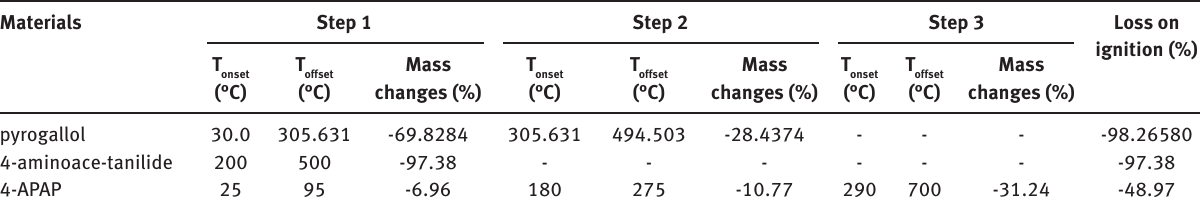
Table 1: Effect of temperature on mass changes TG curves of materials Materials